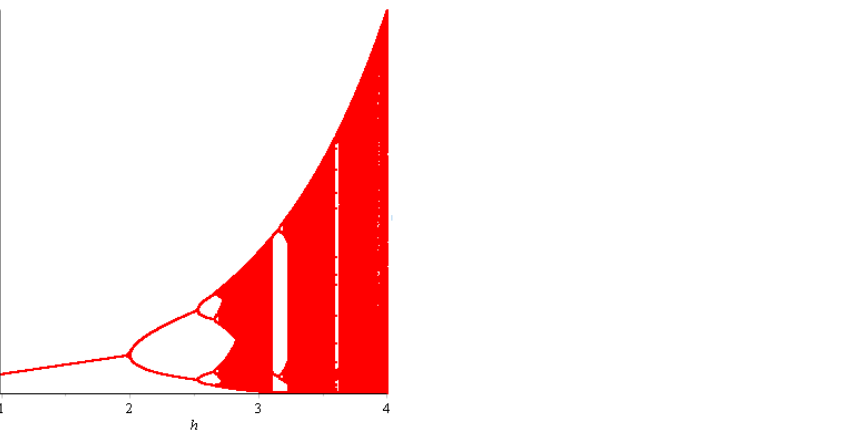
Figure 1. Flip bifurcation diagram of the boundary fixed point E 1 ( 0, hm )